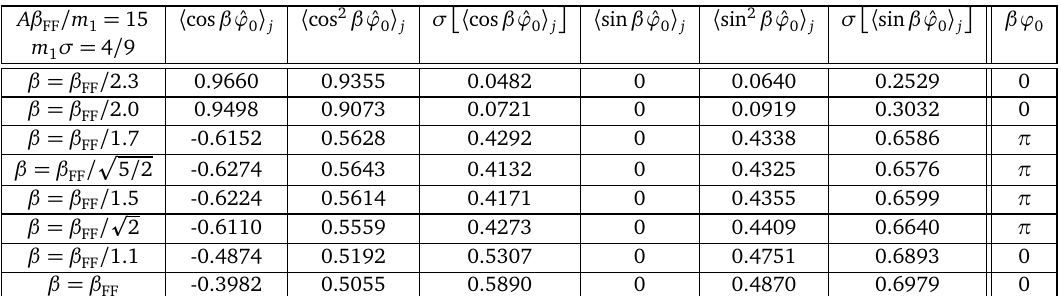
Table B.2: The zero mode in the quantum inhomogeneous state from TCSA with = 30 and m 〉 e L = 20. 〈 denotes the expectation value of operator c j 1 O (cid:2) 〈 (cid:3) 〉 inhomogeneous initial state, while σ is the standard deviation characterising j O the fluctuations.